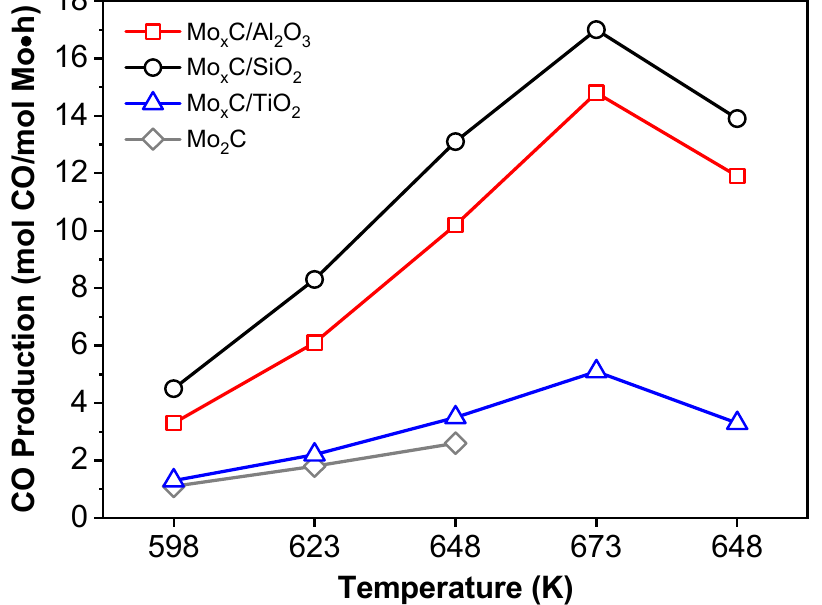
Figure 9. CO production per mol of Mo as a function of reaction temperature in RWGS over Mo x C/support and unsupported reference Mo 2 C catalysts. Reaction conditions: m cat = 150 mg, CO 2 /H 2 /N 2 = 1/3/1, GHSV = 3000 h − 1 , P = 0.1 MPa.